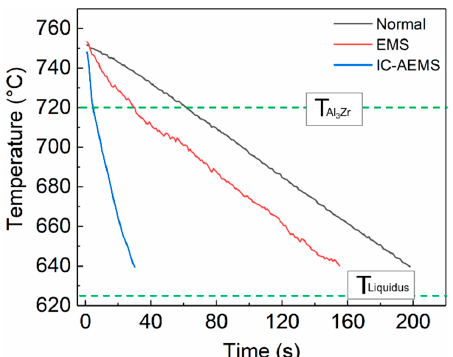
Figure 2. Cooling curves of Al-Zn-Mg-Cu-Zr alloy with three different treatments in liquid state. The dotted line represents the equilibrium precipitation temperature of primary Al 3 Zr and the liquidus of Al-Zn-Mg-Cu-Zr alloy.